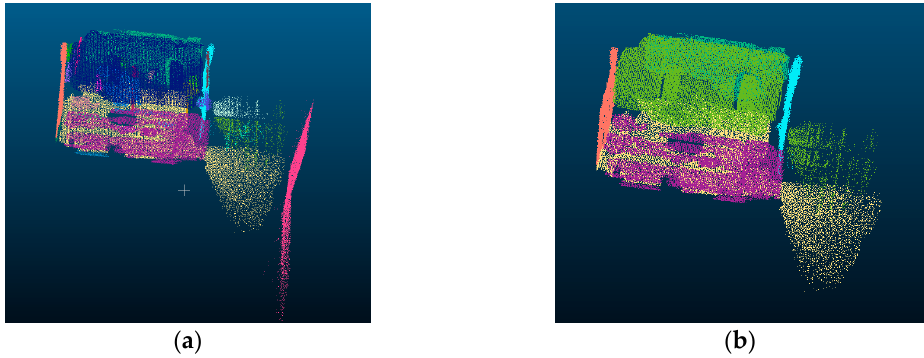
Figure 13. Scenario 1: ( a ) Plane Segments; ( b ) Wall Clusters after the application of the merging logic.